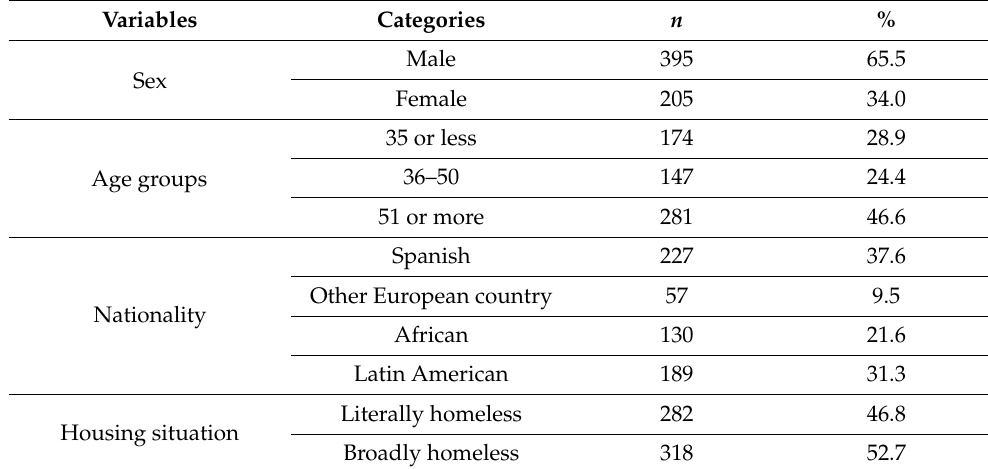
Table 1. Description of the sample.